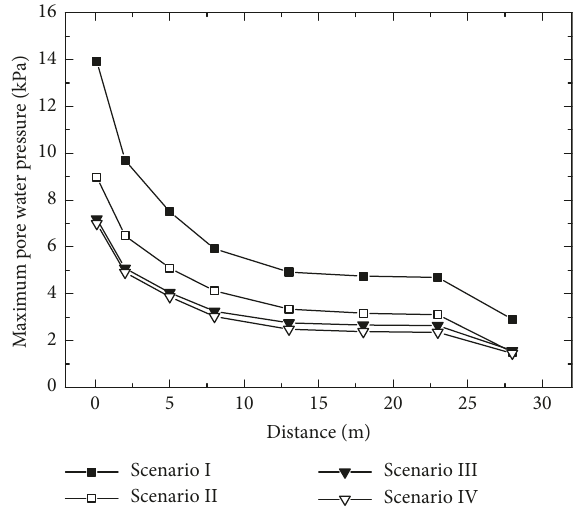
Figure 19: Trend of the maximum excess pore pressure.